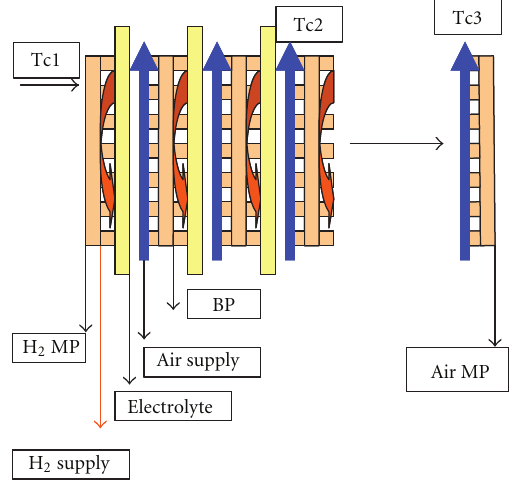
Figure 9: Schematic of fuel cell stack